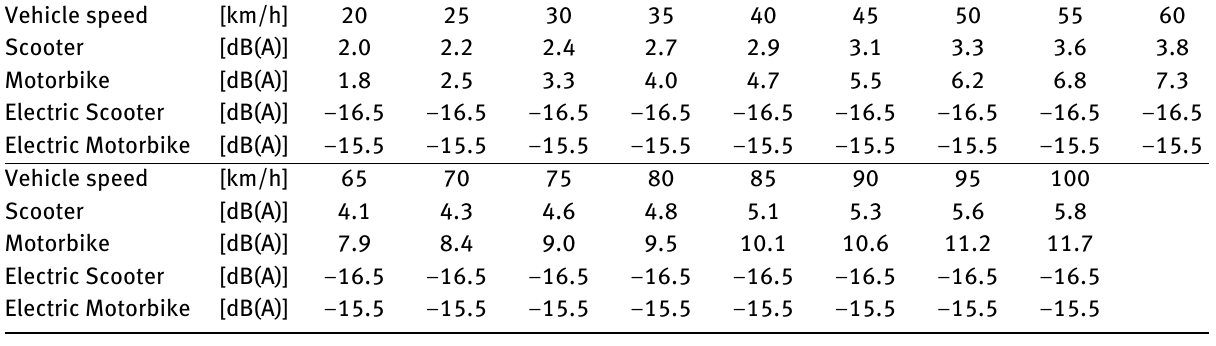
Table 3: L Aeq correction related to car emissions for various PTWs for discrete speeds in 5 dB steps in the range of 20 km/h to 100 km/h. Vehicle speed